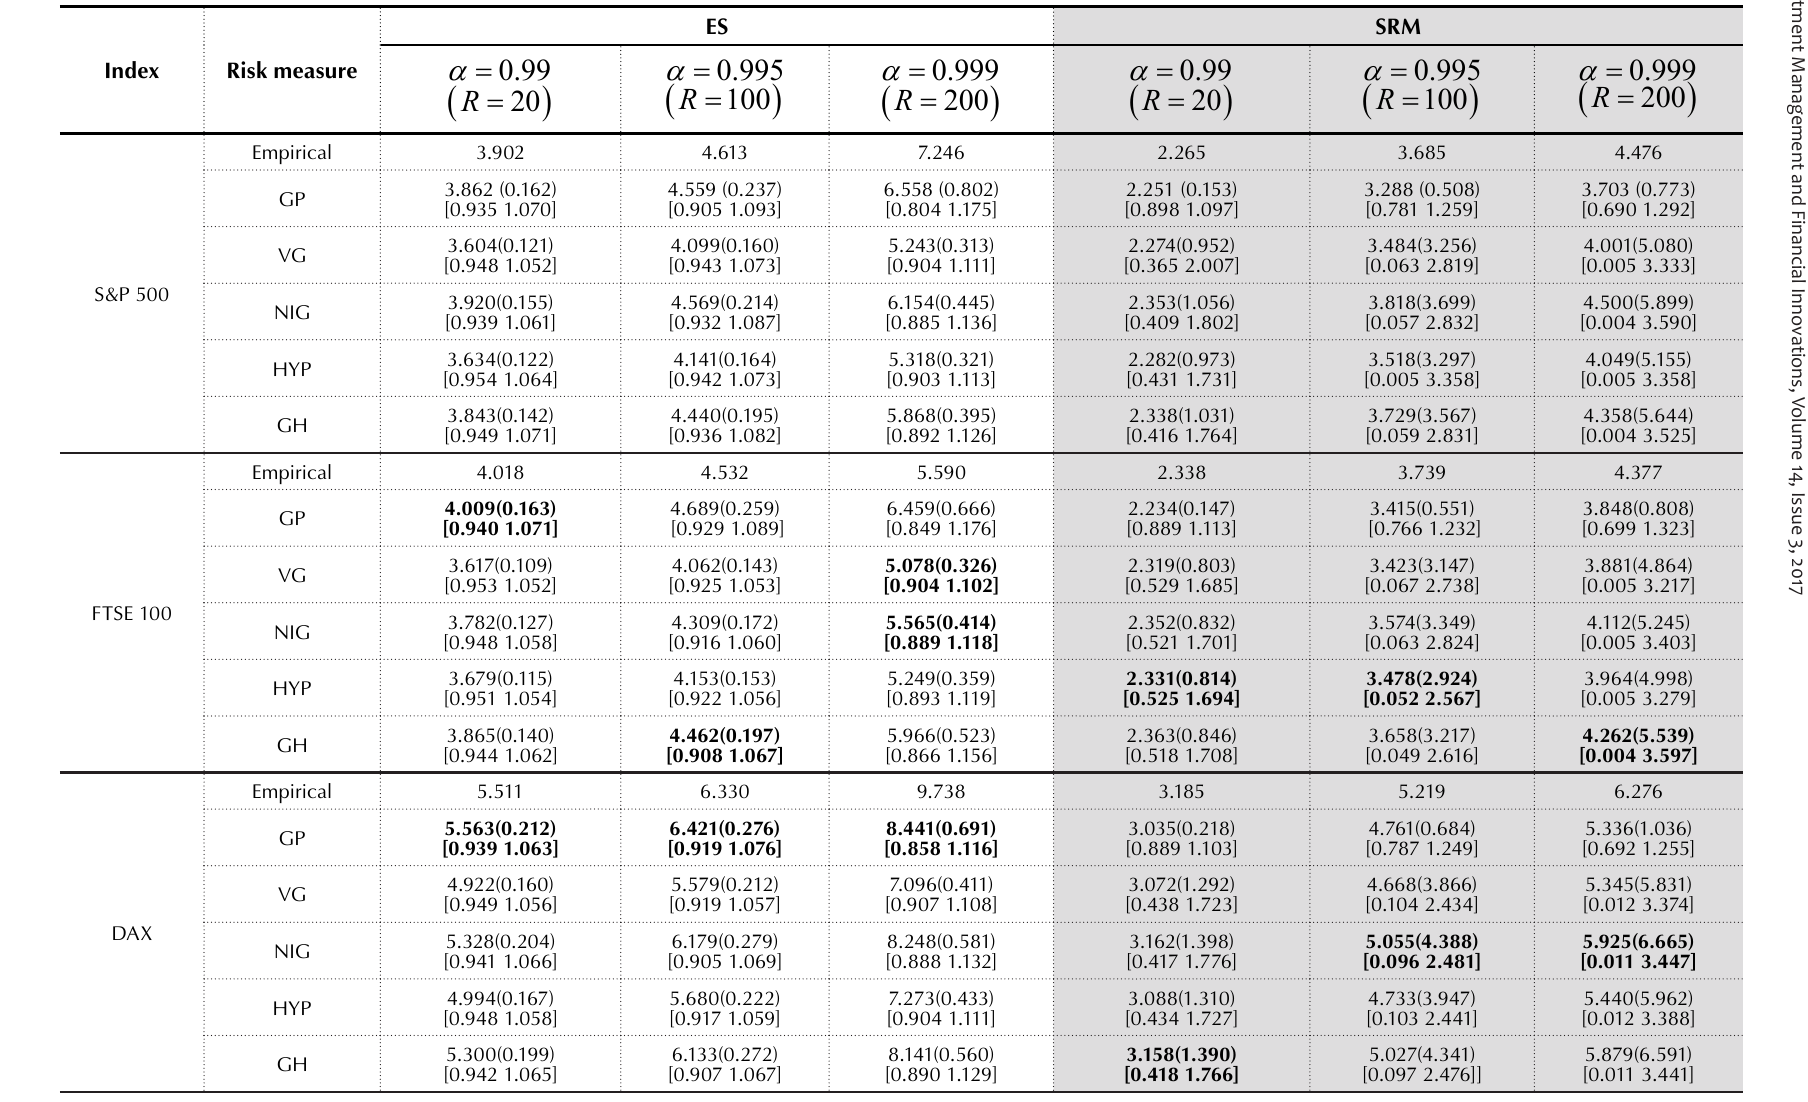
Table 4. Estimates of ES and Lévy spectral risk measures for futures